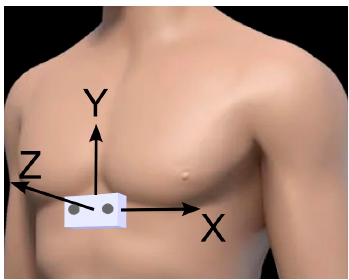
Figure 8. Accelerometer axes (positive direction) for chest module.